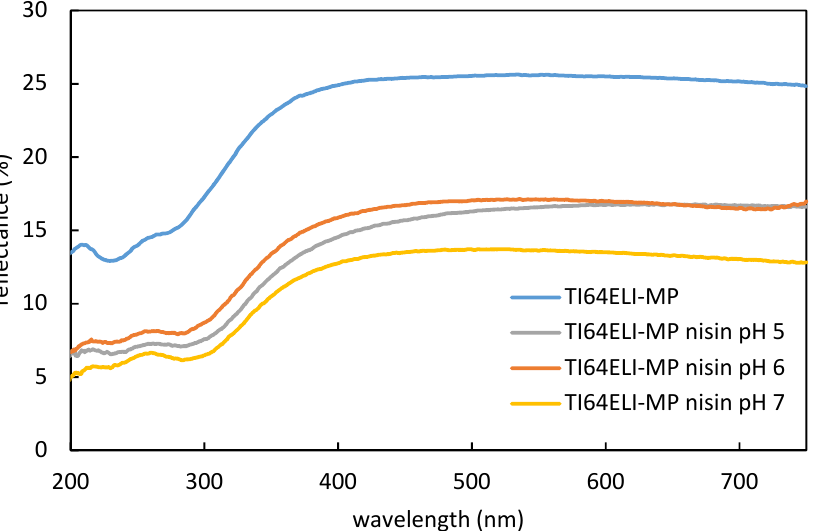
Figure 3. UV–Vis reflectance spectra of the MP samples both bare and surfaces functionalized with processes at different pH values.